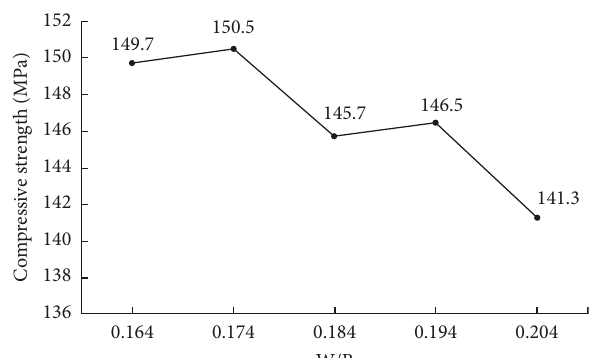
Figure 3: Influence of the W/B ratio on the compressive strength of UHPFRC.